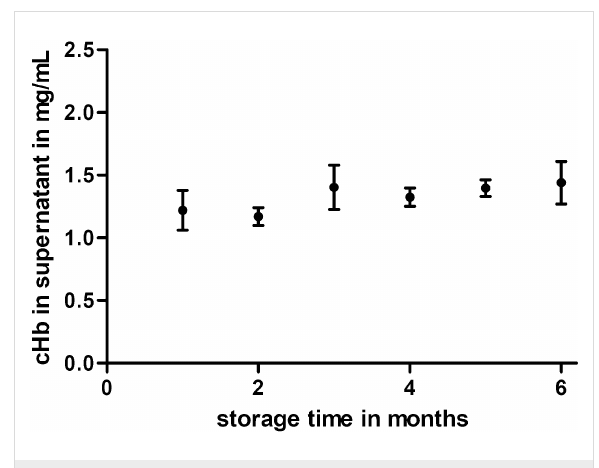
Figure 3: Concentration of free hemoglobin in the supernatant of HbMP suspensions. Measuring points are means with SD from three batches of